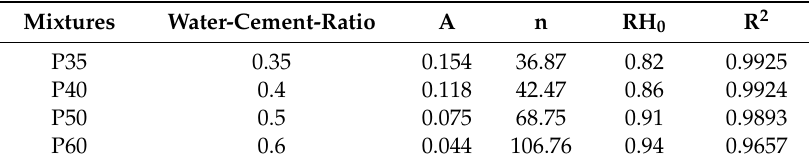
Table 3. Parameters of Equation (11) for OPC binders.